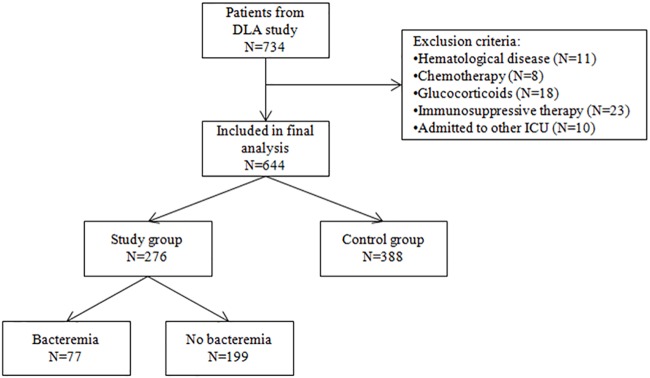
Enrollment flow chart.DLA = Dynamic Light Application.